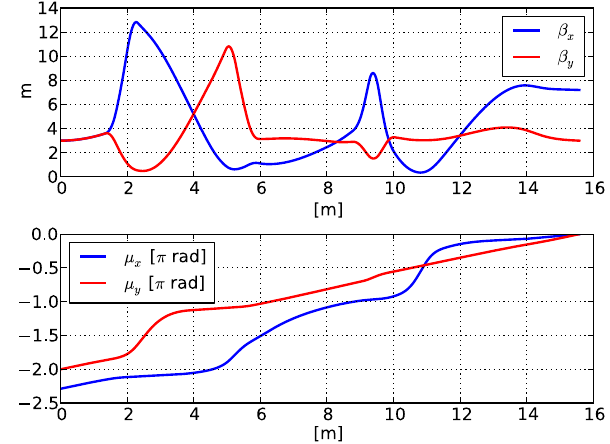
FIG. 7. (cid:2) x , (cid:2) y and (cid:10) x , (cid:10) y along the proton gantry in vacuum (CP at